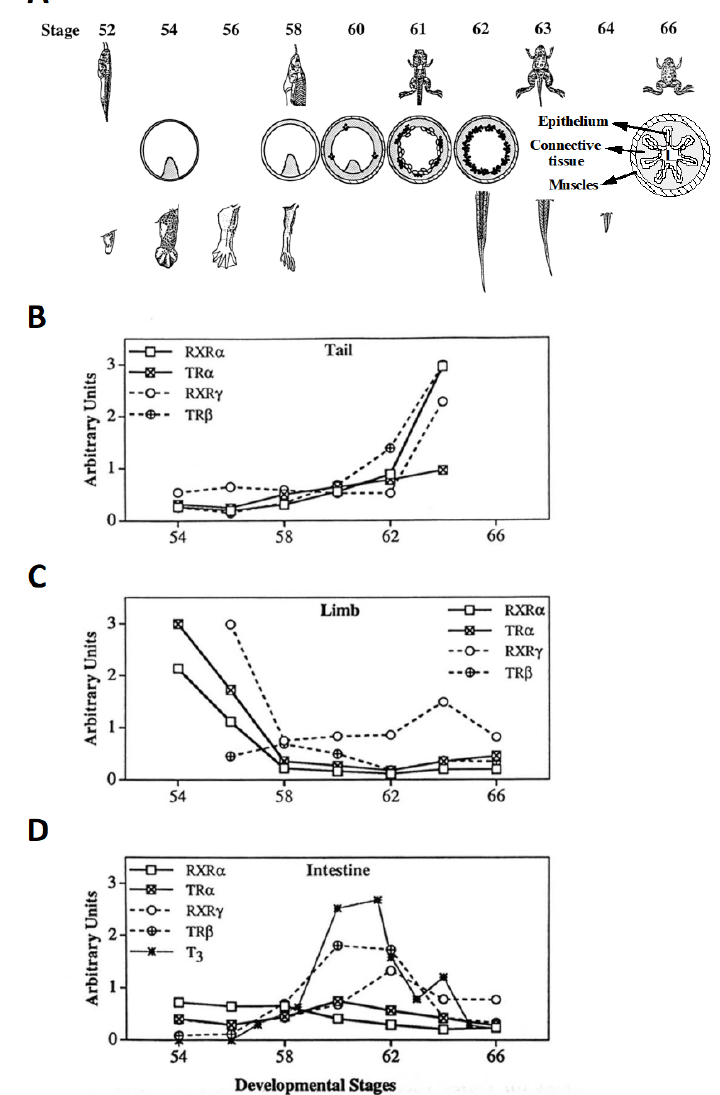
Figure 3. The expression of TR and RXR genes temporally correlates with organ-specific metamor- phosis. ( A ). Temporal regulation of metamorphic organ transformations in Xenopus laevis . Tadpole developmental stages and ages are based on [51]. The tails at stages NF62-NF66 are drawn to the same scale to show resorption (no tail is left by stage NF66), while the tadpoles, intestinal cross-sections (stages NF54-NF66), and the hindlimbs (stages NF52-NF58) at different stages are not to scale in order to show stage-dependent morphological changes during metamorphosis. Tadpole small intestines have a single epithelial fold, where connective tissue is abundant, while frogs have a multiple-folded intestinal epithelium, with thick connective tissue and muscles. Black dots, proliferating adult in- testinal epithelial cells; circles, apoptotic larval intestinal epithelial cells; L, intestinal lumen. ( B – D ). TR-subtype-dependent temporal regulation of TR and RXR expression in the hindlimb, intestine, and tail. Note that in general, the mRNA levels are high when the organs undergo metamorphosis. During tail resorption (stages NF62-NF66), TR β expression is strongly upregulated, while TR α expression is only moderately increased ( B ). In contrast, during limb morphogenesis (stages NF54-NF58), TR α mRNA level is high, while TR β is low ( C ). During intestinal remodeling, TR β expression is strongly upregulated, while TR α mRNA level is slightly increased ( D ). Adapted from